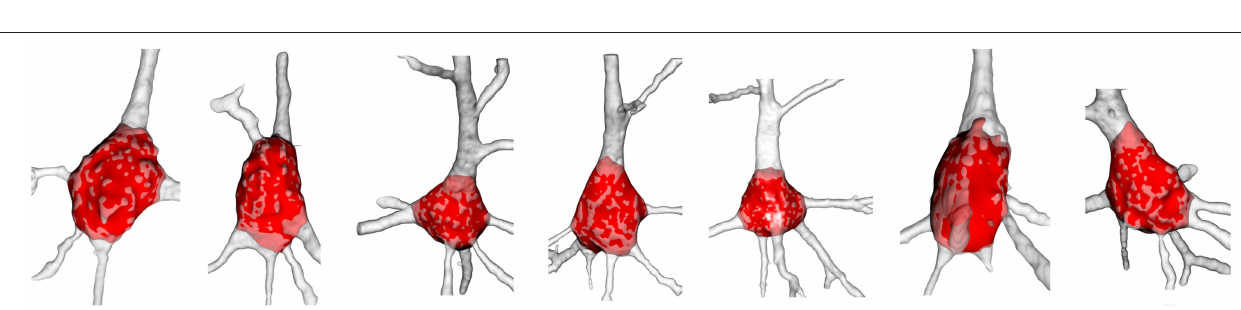
FIGURE 7 | Examples of final soma result. The reconstructed neuron is colored white with low opacity and its automatically extracted soma is denoted in red. The surface of the extracted soma placed inside the dendrite is shaded light